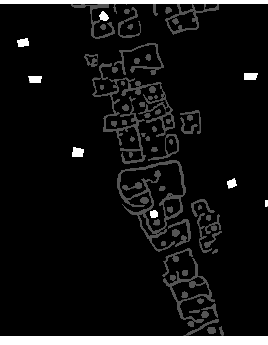
Fig. 3 Subsets of the Quickbird images of 2006 and 2008, respectively (280 x 350 pixels)